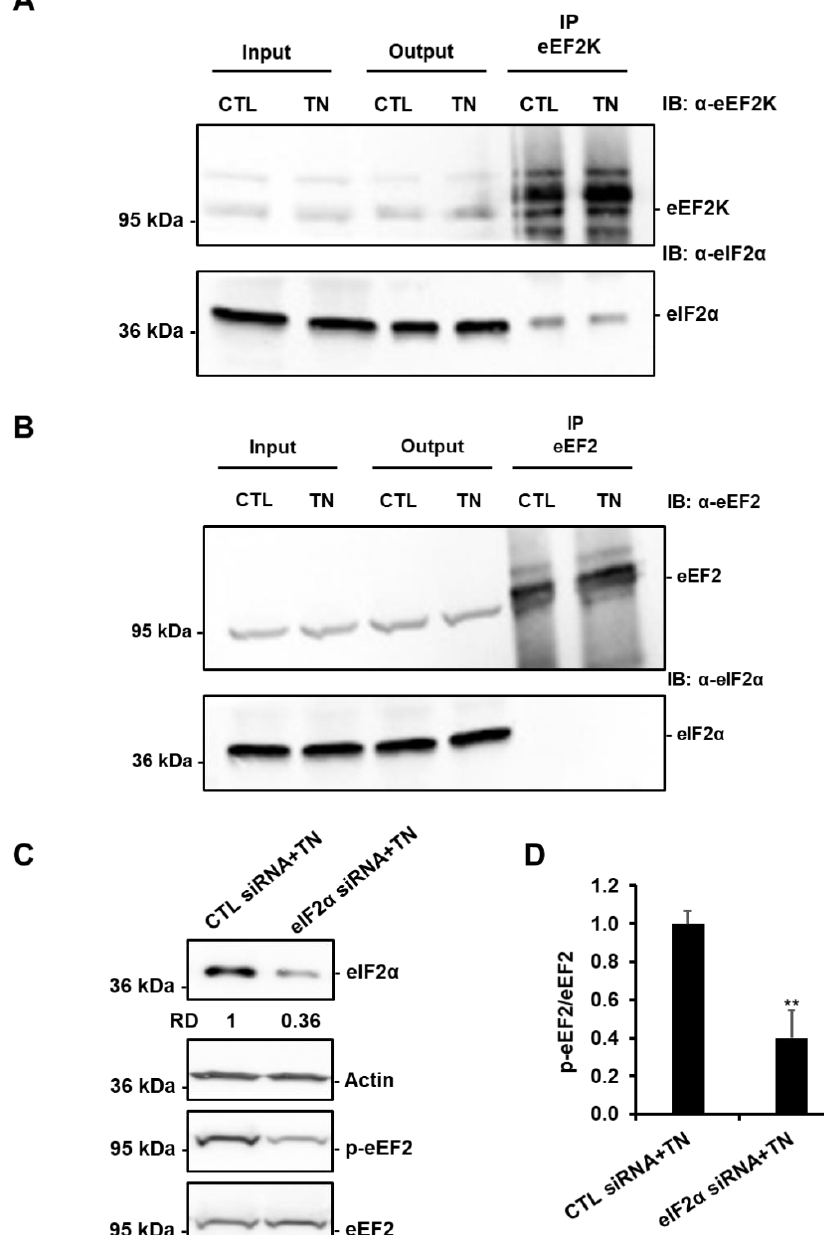
Figure 8. eIF2 α is involved in the regulation of eEF2 phosphorylation in response to ER stress. eEF2K ( A ) and eEF2 ( B ) were immunoprecipitated from lysates of H9c2 cells treated or not with 10 µ g / mL tunicamycin (TN), and the presence of eEF2K or eEF2 and eIF2 α were analyzed by Western blot (n = 3). ( C , D ) H9c2 cells were transfected with control or eIF2 α siRNA for 24 h, treated with tunicamycin (TN) for 1h30, and the level of eIF2 α or phospho-eEF2 was analyzed by Western blot (RD: Relative density). The ratio of p-eEF2 vs. total eEF2 is presented in the bar graph. Error bars, S.E.M. (n = 4). ** P < 0.01 versus CTL siRNA +